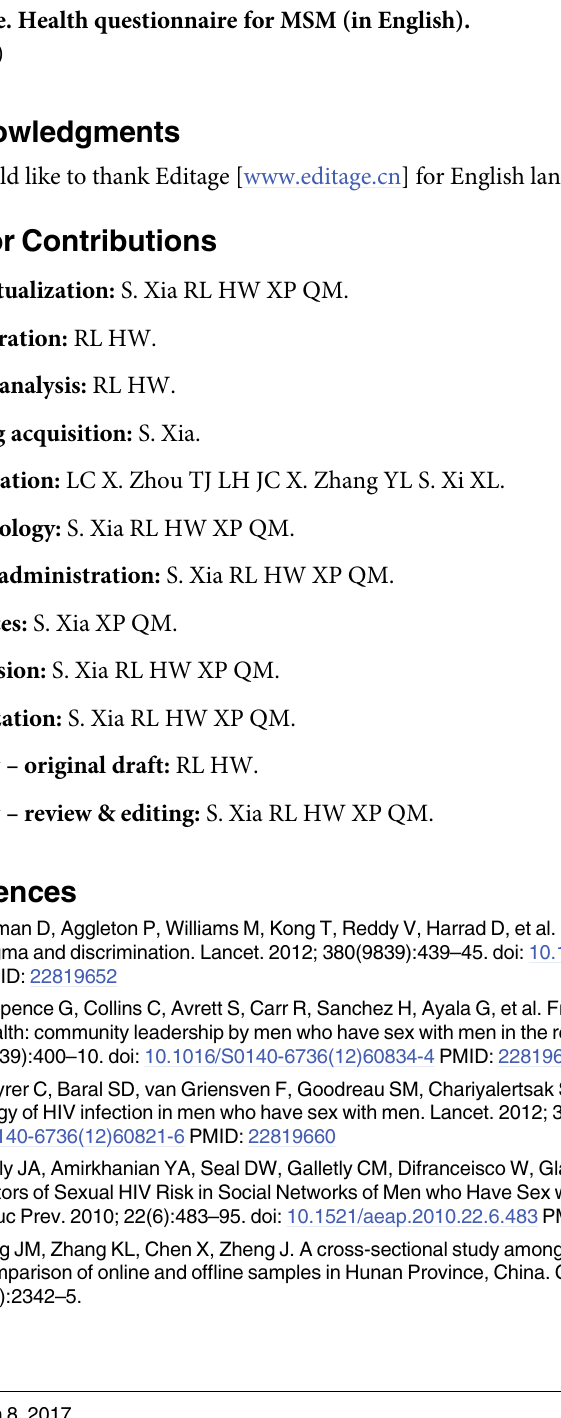
S1 Table. Health questionnaire for MSM (in Chinese). S2 Table. Health questionnaire for MSM (in